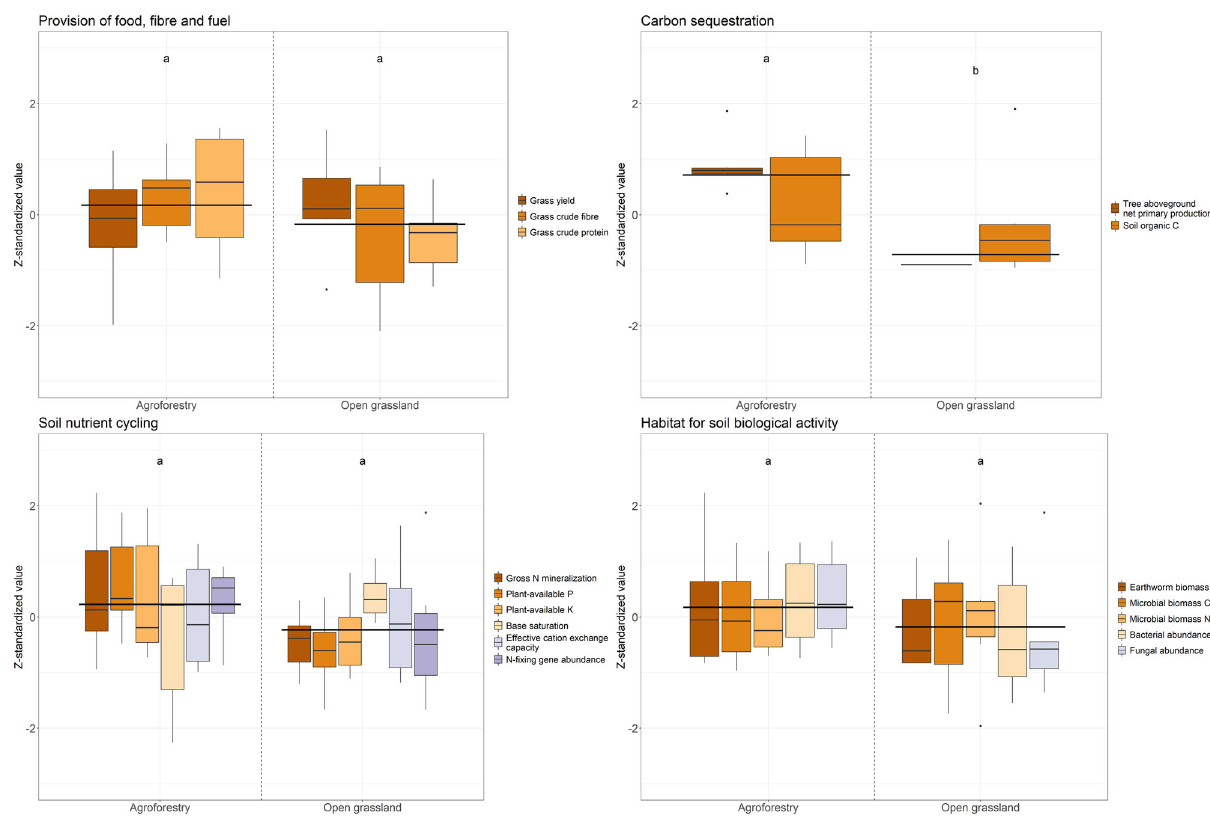
Fig. 2 Ecosystem functions and their indicators in grassland agroforestry and open grassland, measured at two sites in Germany. Each indicator is z - standardized: (actual value − mean value across replicate plots and sites)/standard deviation. The black horizontal line indicates the mean of the standardized values of indicators for a speci fi c ecosystem function. Boxplots indicate the 25th quartile, median and 75th quartile, and whiskers are 1.5 times the interquartile range. Mean, standard error and N values of indicators are given in Supplementary Table 4. For each ecosystem function, different letters indicate signi fi cant differences between grassland agroforestry and open grassland (linear mixed effects models at P ≤ 0.05; Supplementary Table